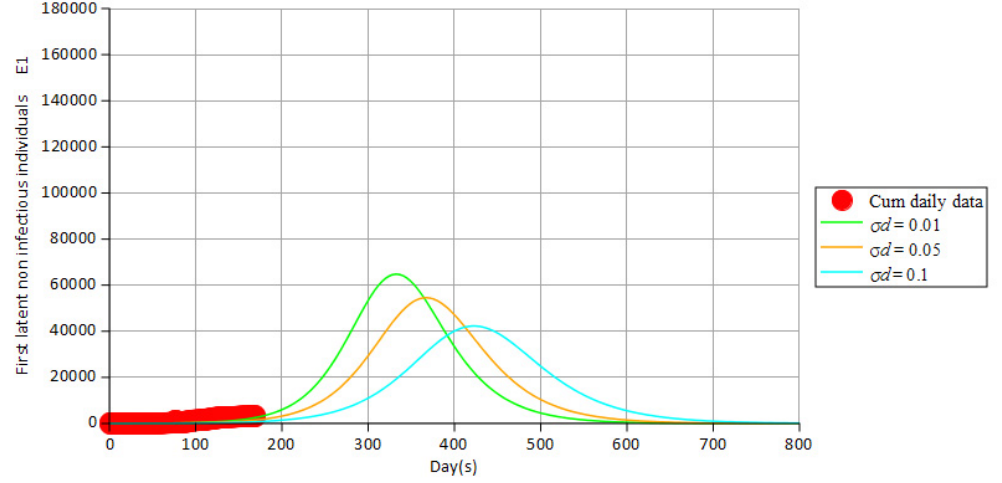
Figure 9. Effect of social distancing σ d = 0.01, 0.05, 0.1 with cumulative daily infectious individuals (red) and exposed non infectious (first latency) individuals E 1 ( t ) using parameters as in Table